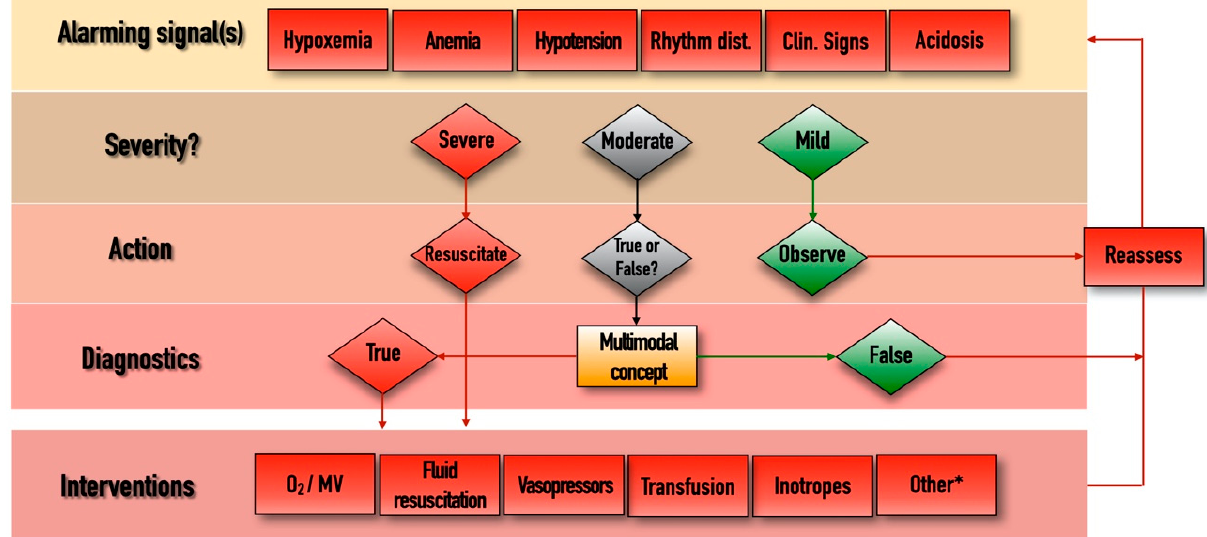
Figure 2. Management algorithm. Rhythm dist., cardiac rhythm disturbances; Clin, clinical; MV, mechanical ventilation. *, extracorporeal renal replacement therapies, immunomodulation, other adjuvant therapies. Whenever an